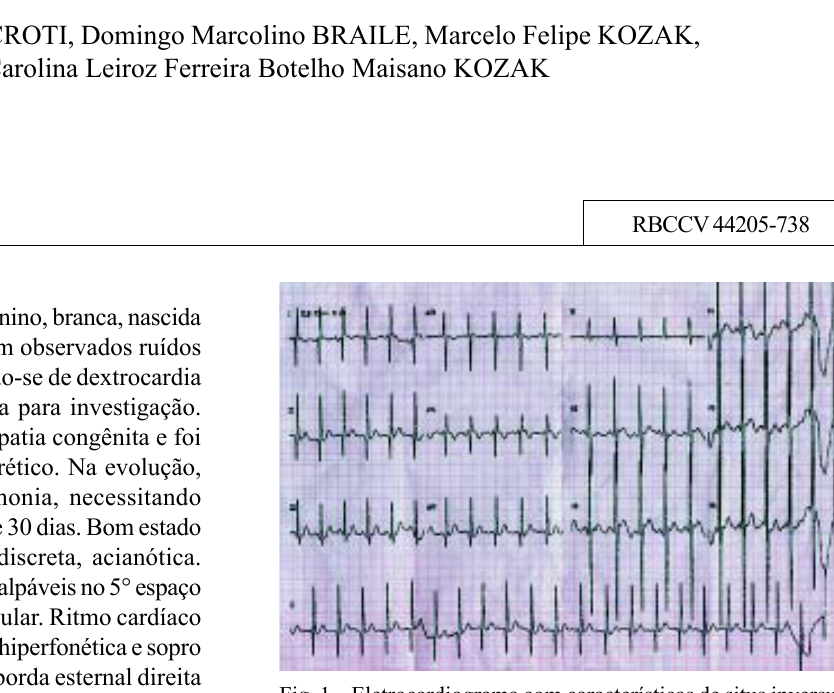
Fig. 1 – Eletrocardiograma com características de situs inversus e dextrocardia, obtido com derivações precordiais à direita e sem inversão de eletrodos nos